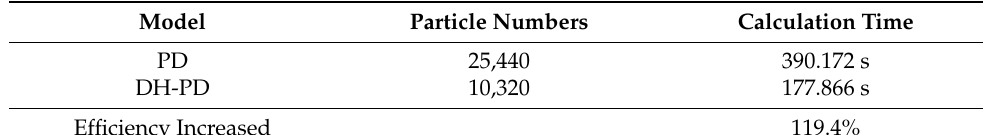
Figure 19. Snapshots of simulated crack propagation in the double-edged notched specimen using the DH-PD model ( left ) and traditional PD model ( right ). Table 3. Calculation time and efficiency of the two models.